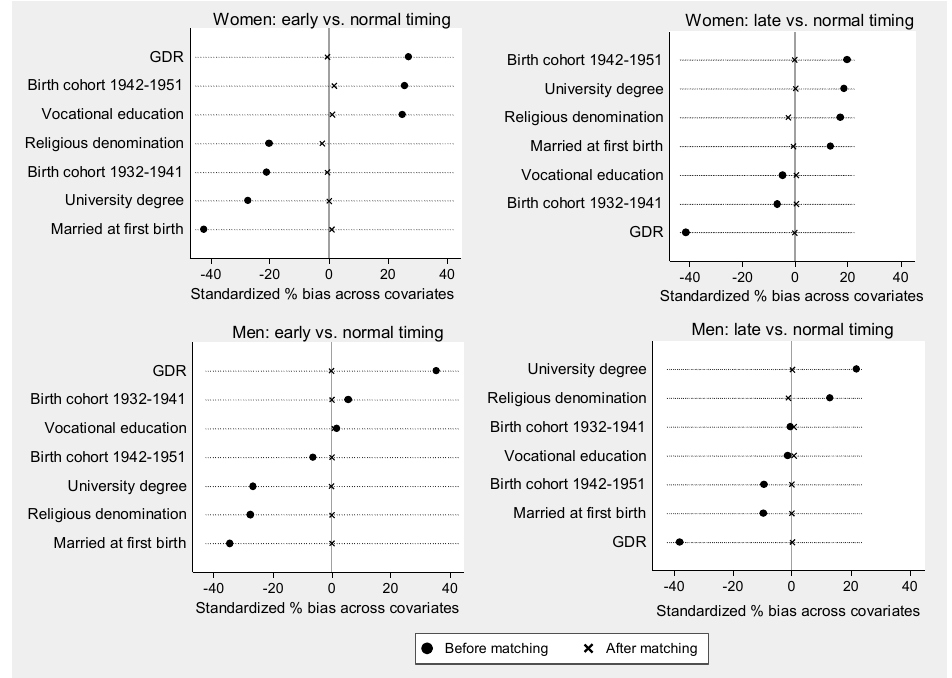
Figure 2 : Standardized percentage bias for each covariate before and after matching, by sex and